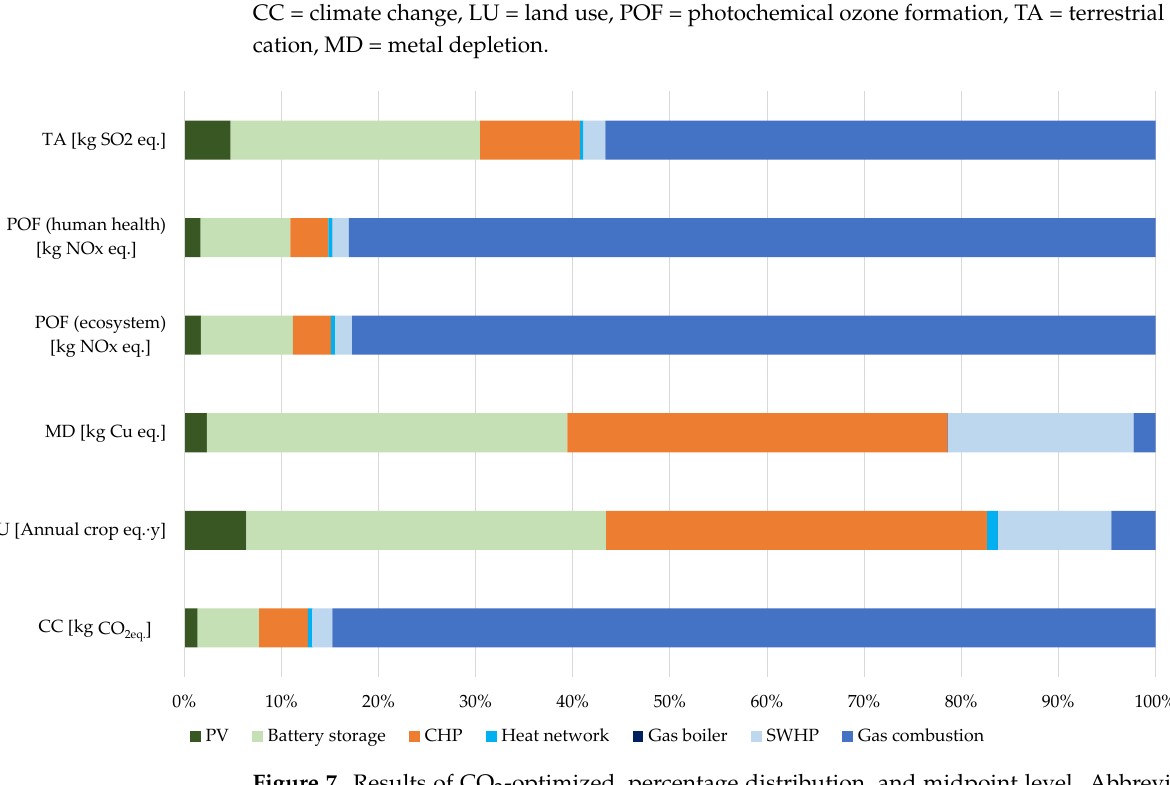
Figure 7. Results of CO 2 -optimized, percentage distribution, and midpoint level. Abbreviations: CC = climate change, LU = land use, POF = photochemical ozone formation, TA = terrestrial acidification, MD = metal depletion. 3.3. LCA results at endpoint level.